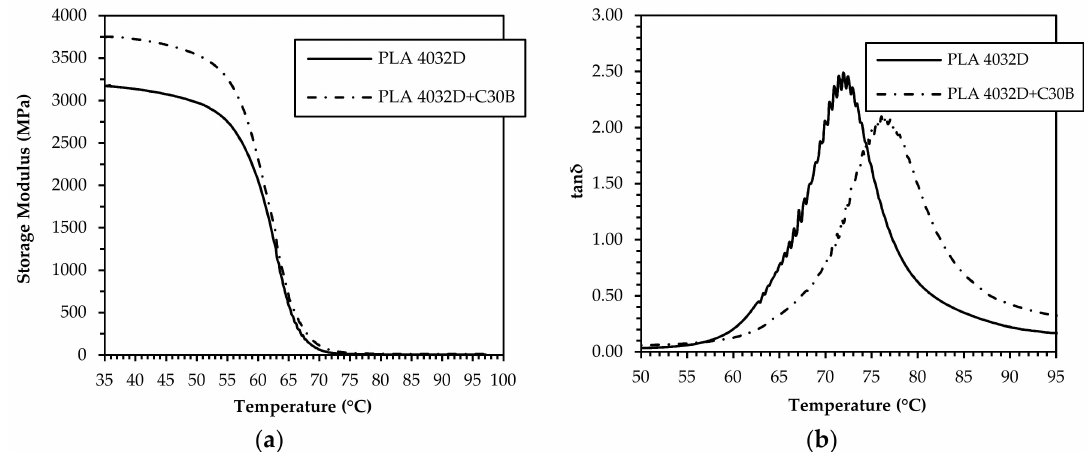
Figure 3. Storage modulus ( a ) and tan δ ( b ) of PLA 4032D and PLA 4032D+C30B filaments.